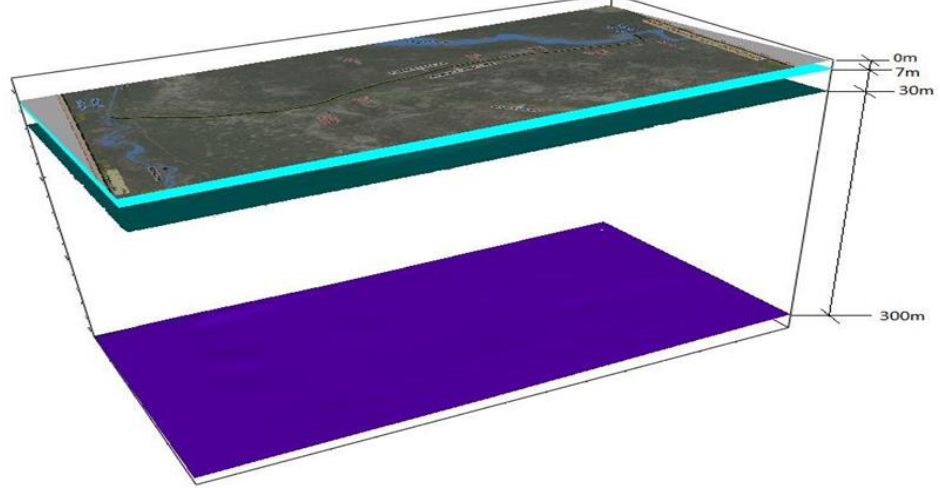
Figure 3. Three-Dimensional Pictorial View of Model Layers.